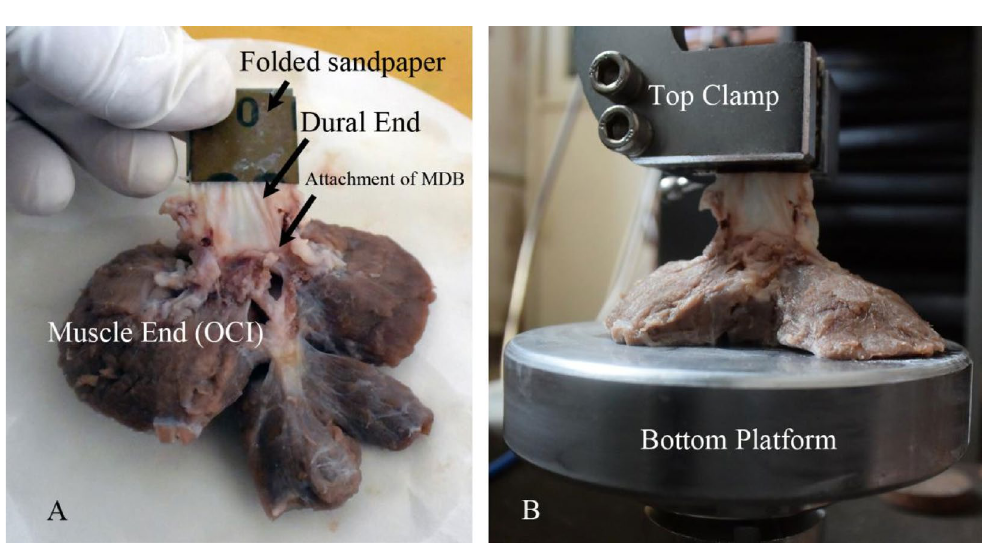
Figure 2. Illustration of preparation ( A ) and fixation ( B ) of the test